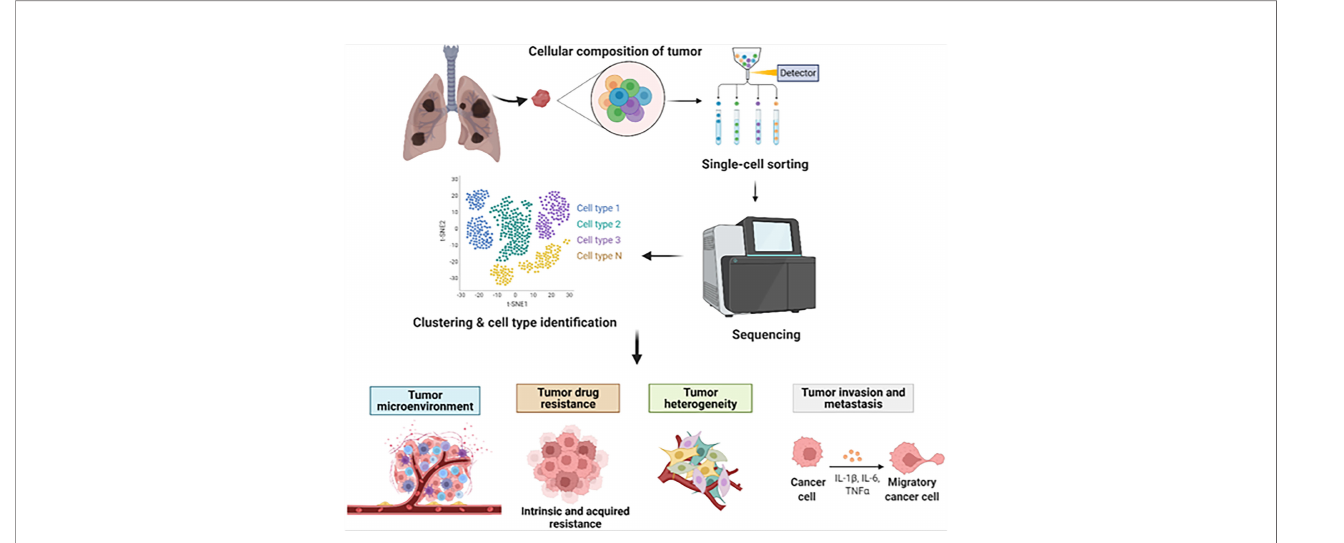
FIGURE 1 | Decoding lung cancer at single-cell